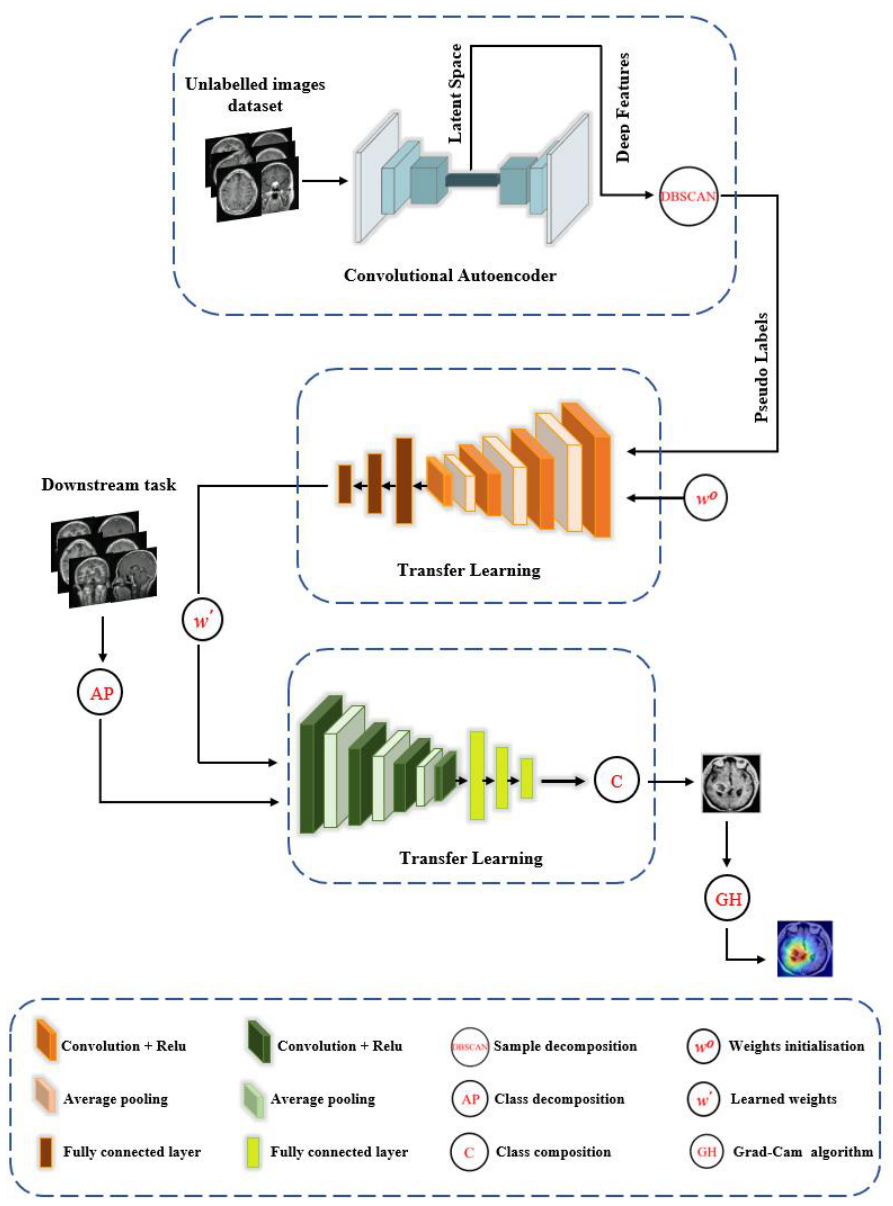
Figure 1. The framework of the XDecompo